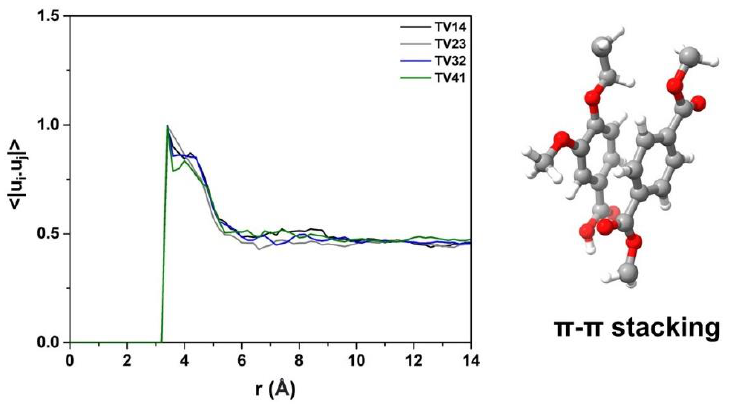
Figure 10. The orientation correlation function of the benzene ring in different blend ratios of PET/PEV.